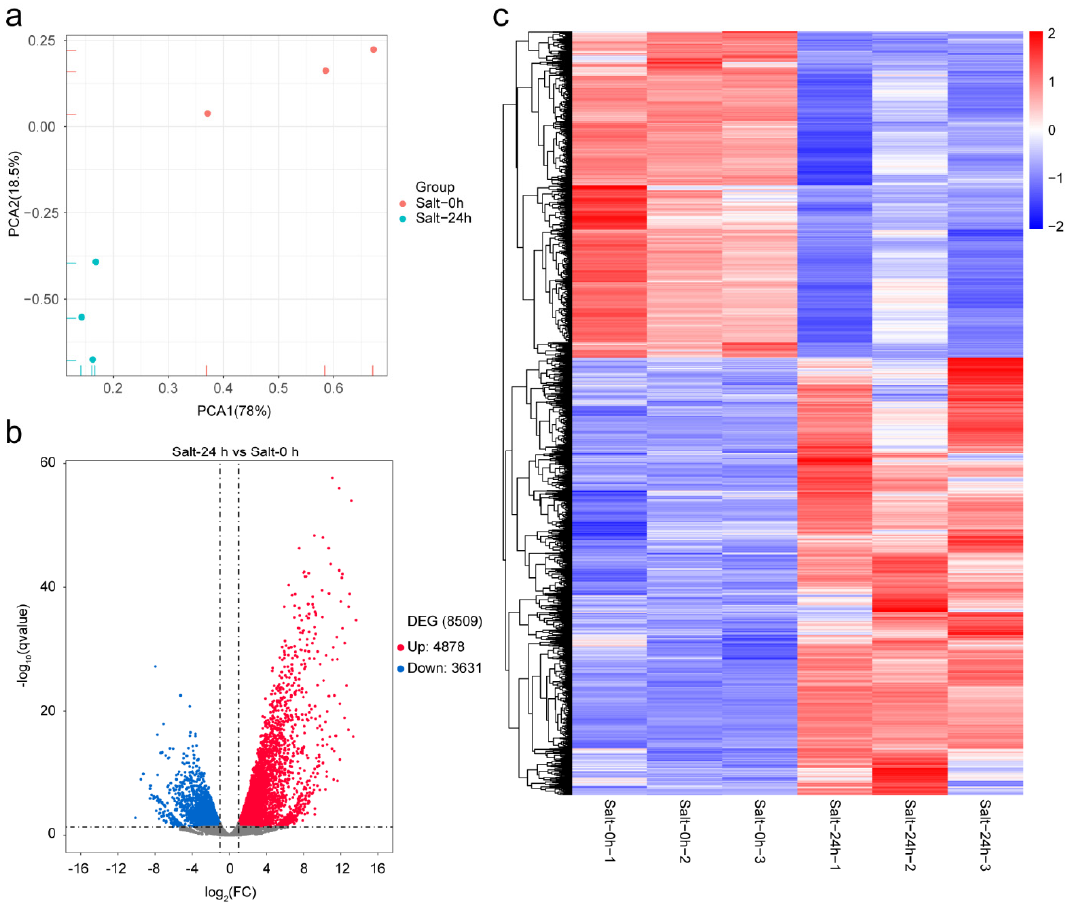
Figure 1. Spatiotemporal gene expression patterns under salt stress treatment. ( a ) Principal component analysis (PCA) of the samples at 0 and 24 h post − treatment based on the normalized expression levels of differentially expressed genes (DEGs). ( b ) Volcano plot of the differential expression levels of up ‐ regulated and down − regulated DEGs in eggplant roots under salt stress. ( c ) Heat map of correlations between the transcript expression levels of DEGs in eggplant roots treated with salt stress. FPKM values were used for the hierarchical cluster analysis after the normalization of FPKM values with Z ‐ score.